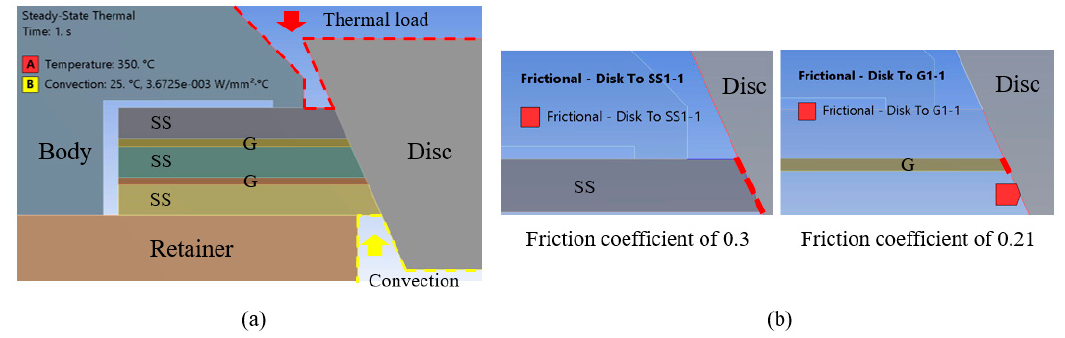
Figure 13. Analysis condition of thermal simulation. ( a ) Temperature and convection, ( b ) friction coefficient. SS, stainless steel; G, graphite.